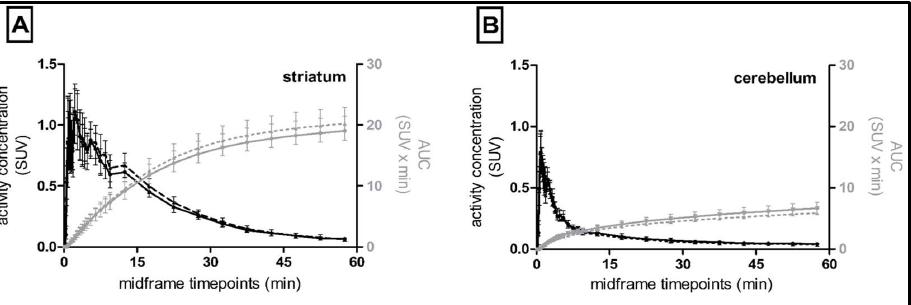
Figure 2. Mean time–activity curves of standardised uptake values (SUV; black lines) and cumulative area under the curves (AUC; grey lines) of control ( n = 7, dashed lines, triangles) and rotenone–treated ( n = 6, solid lines, circles) C57BL/6JRj mice. ( A ) striatum and ( B ) cerebellum, mean ± SD. Table 4. Non–compartmental pharmaokinetic parameters derived from the time–activity curves of [ 18 F]FLUDA in target and reference regions in healthy (ctrl, n = 7) and rotenone–treated (rot, n = 6) C57BL/6JRj mice.